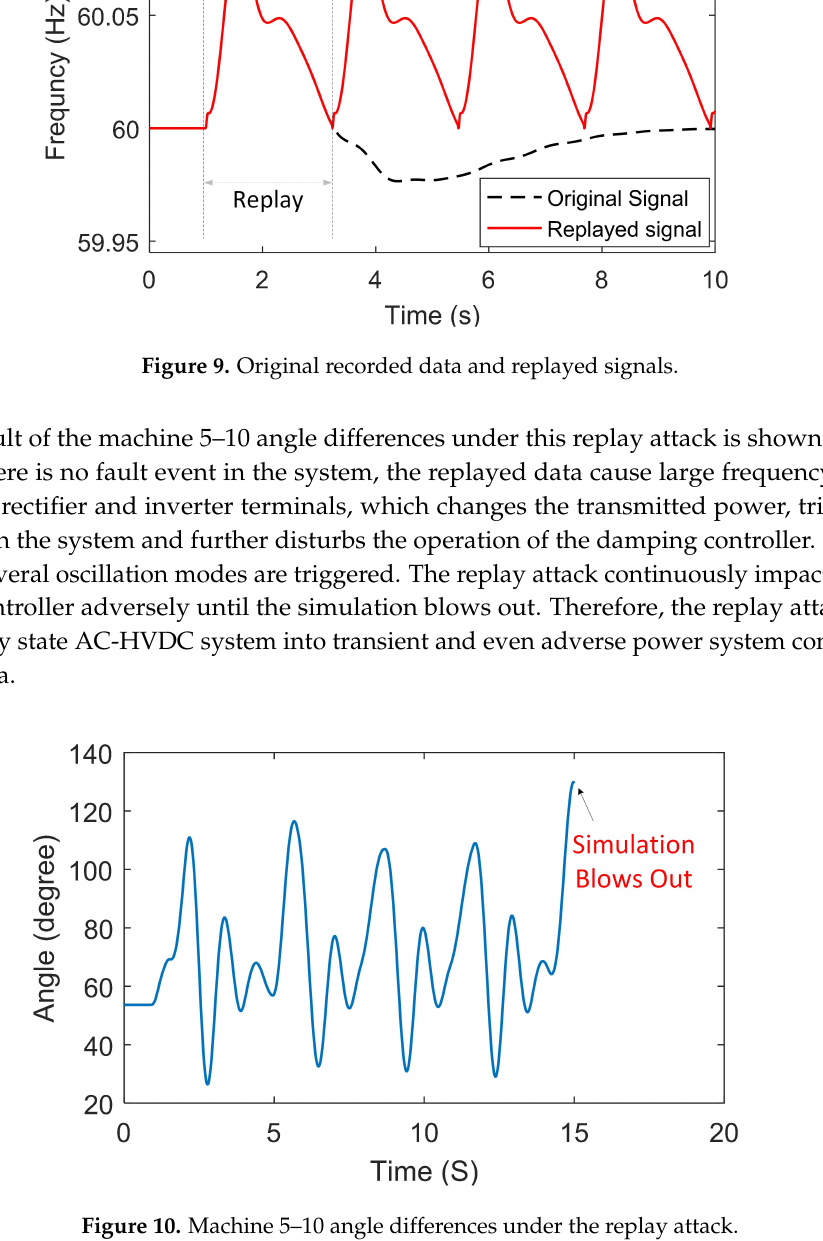
Figure 10. Machine 5–10 angle differences under the replay